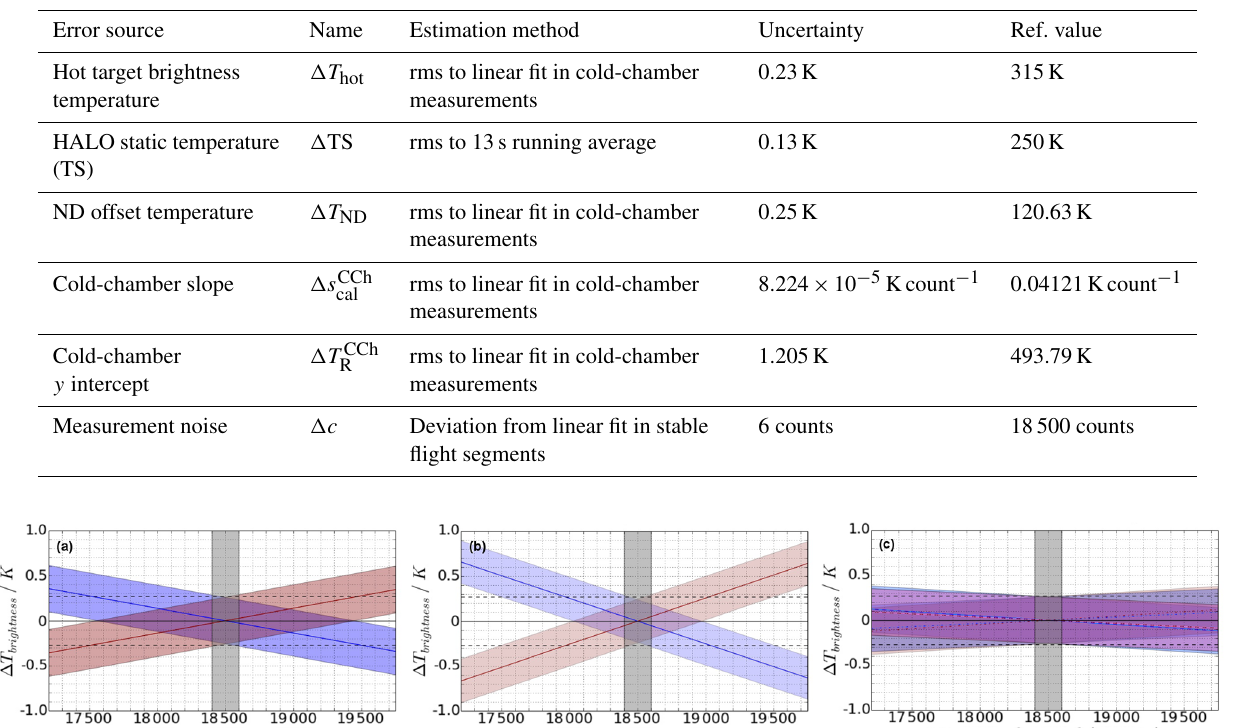
Table 7. Individual uncertainties of values used in brightness temperature calculation.